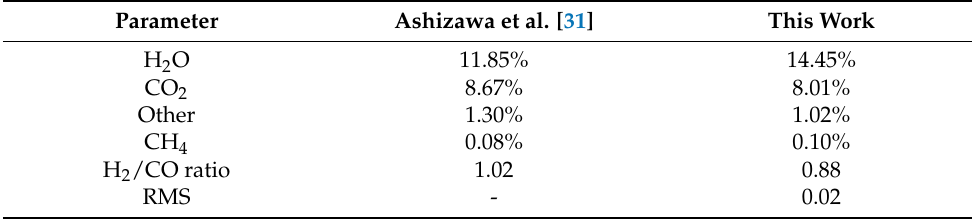
Table 5. Comparison between the results obtained in the model and the experimental work. Parameter Table 5. Cont.